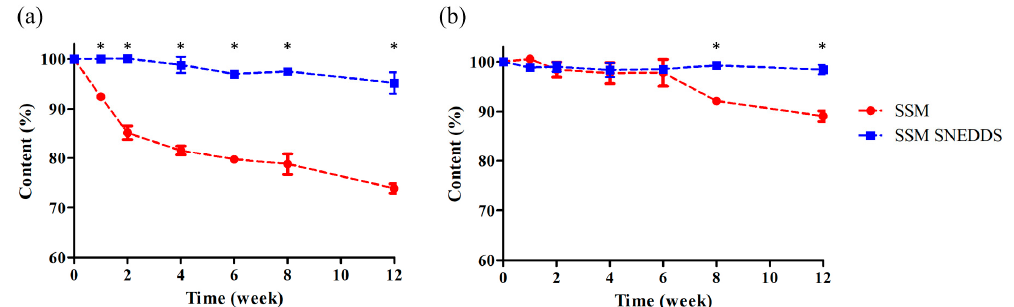
Figure 4. Contents stability of SSM powder and SSM–SNEDDS in the ( a ) acceleration and ( b ) long-term stability examination for 12 weeks. Results are expressed as the mean ± standard deviation of the mean ( n = 3 for each group). * p < 0.001, compared with the SSM group.